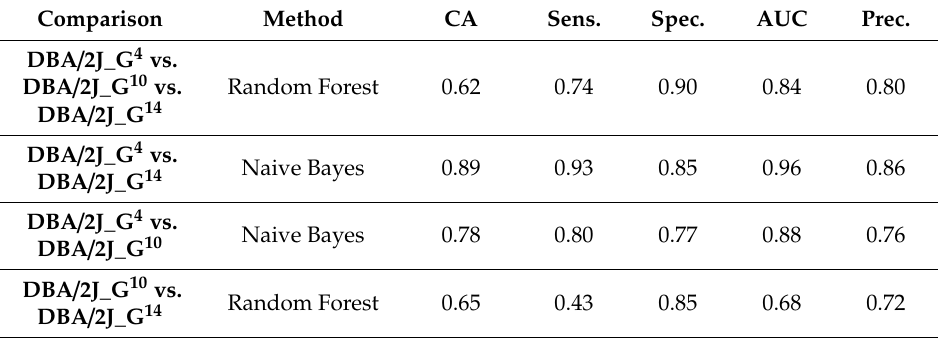
Table 2. Best classifying machine-learning models using the protein panel C4a, CFH, FCN3, APOA4, and TTR.